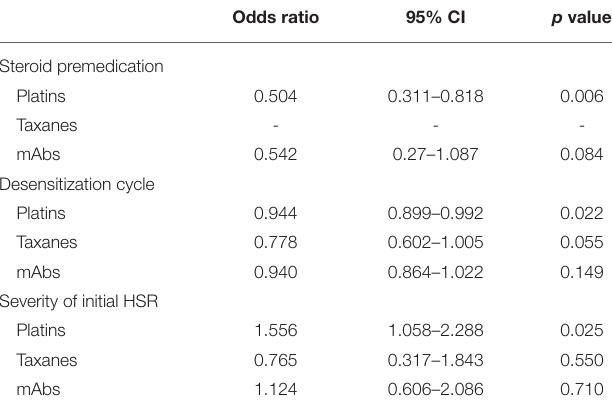
TABLE 4 | Risk factors of moderate to severe BTR by logistic regression analysis.